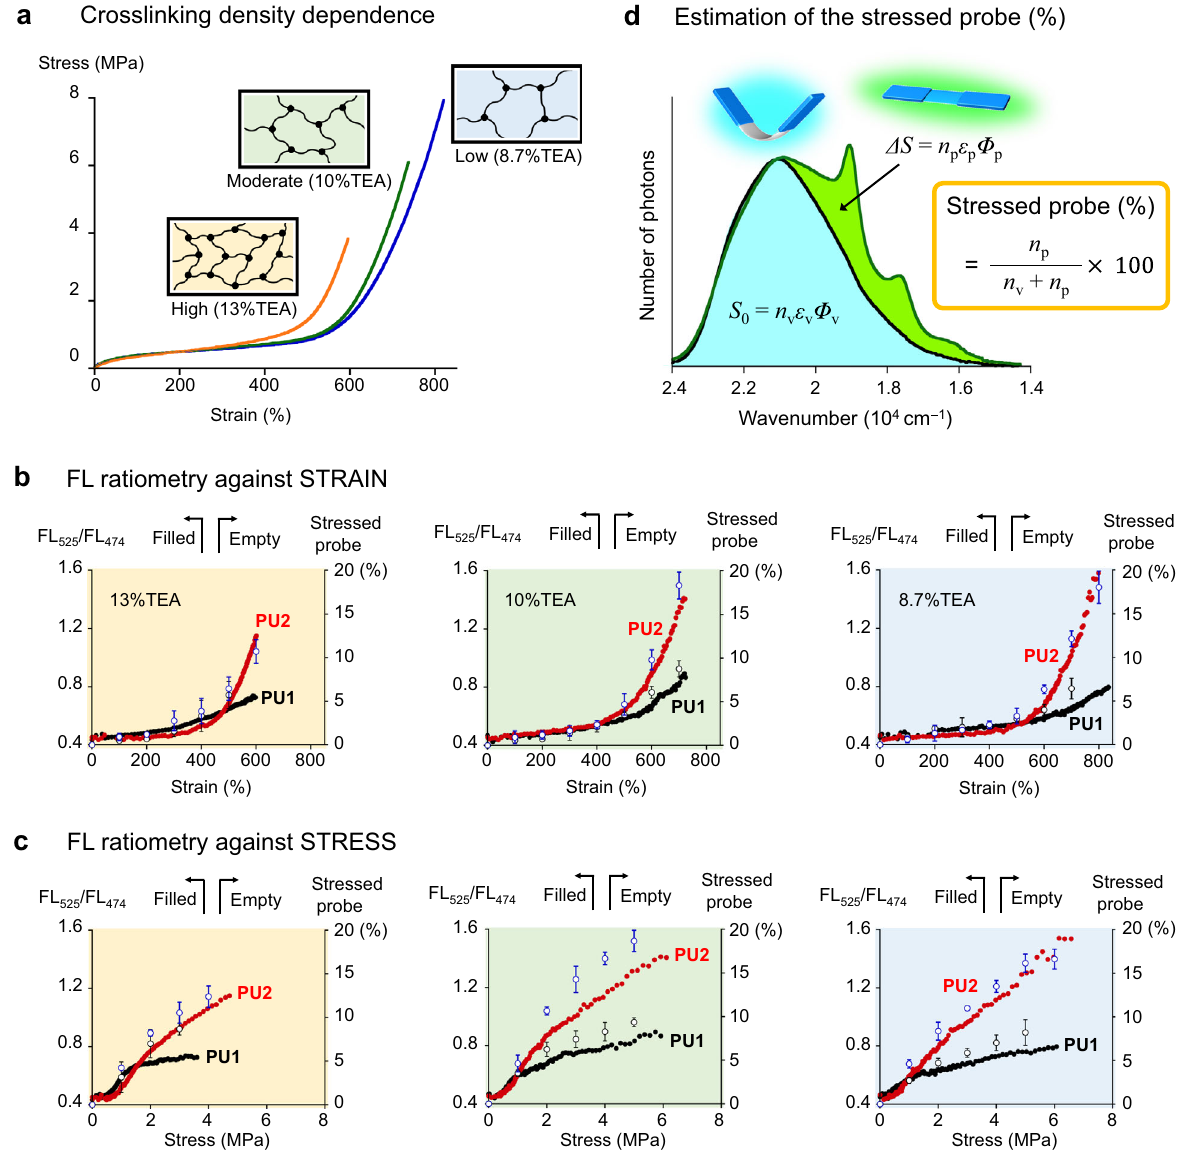
Fig. 5 Quantitative evaluation of the biased local stress concentration in crosslinked polyurethanes. a Stress – strain curves of undoped PU0 with different crosslinking densities. Almost the same curves were obtained for PU1 and PU2 at each crosslinking density (Supplementary Fig. 27). b , c FL ratio ( fi lled) and percentages of the stressed FLAP probe (empty) as a function of macroscopic strain (b) and stress (c) based on tensile testing. Error bars in the stressed probe (%) indicate the standard deviation obtained from three tensile tests. d Estimation of the stressed probe (%) over the threshold force of approximately 100 pN based on the observed FL spectrum. n : number of the FLAP molecules, ε : molar absorption coef fi cient at the excitation wavelength (365 nm), and Φ : FL quantum yield, where the subscripts of “ v ” and “ p ” mean V-shaped (bent) and planar conformers, respectively. See the details in Supplementary Fig.